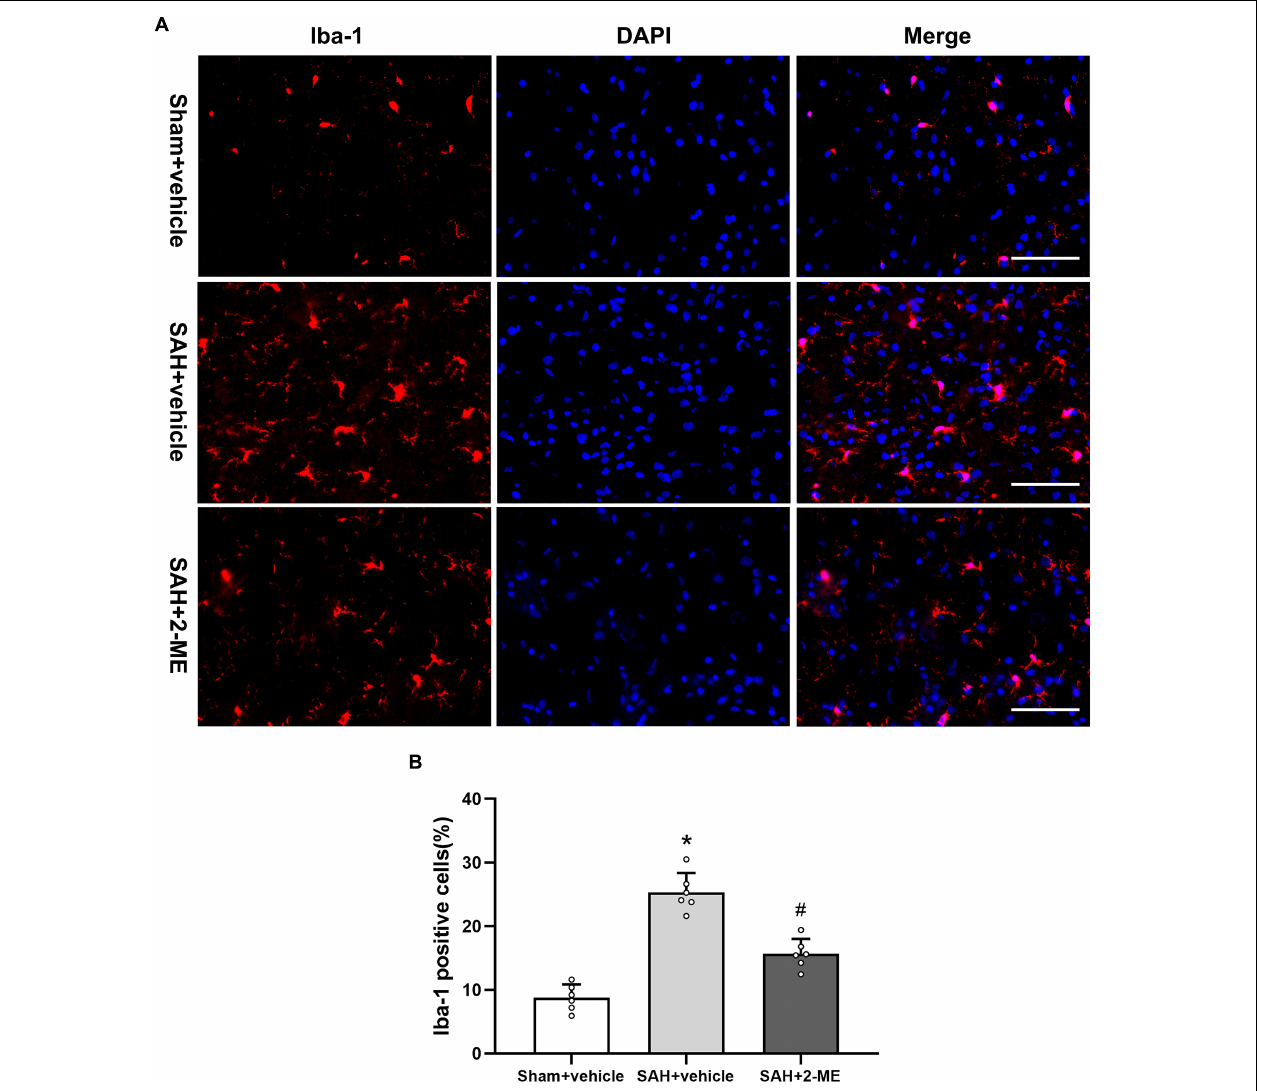
FIGURE 4 | Effect of 2-ME on microglial cell activation. (A) Representative Iba-1/DAPI staining photomicrographs of the ipsilateral basal cortex in different groups (Scale bar = 100 µ m). (B) Quantification of Iba-1-positive cells in different groups, which are expressed as the percentage of total (DAPI + ) cells. Data are shown as mean ± SD ( n = 6 per group). * P < 0.05 vs. the Sham + vehicle group; # P < 0.05 vs. the SAH + vehicle